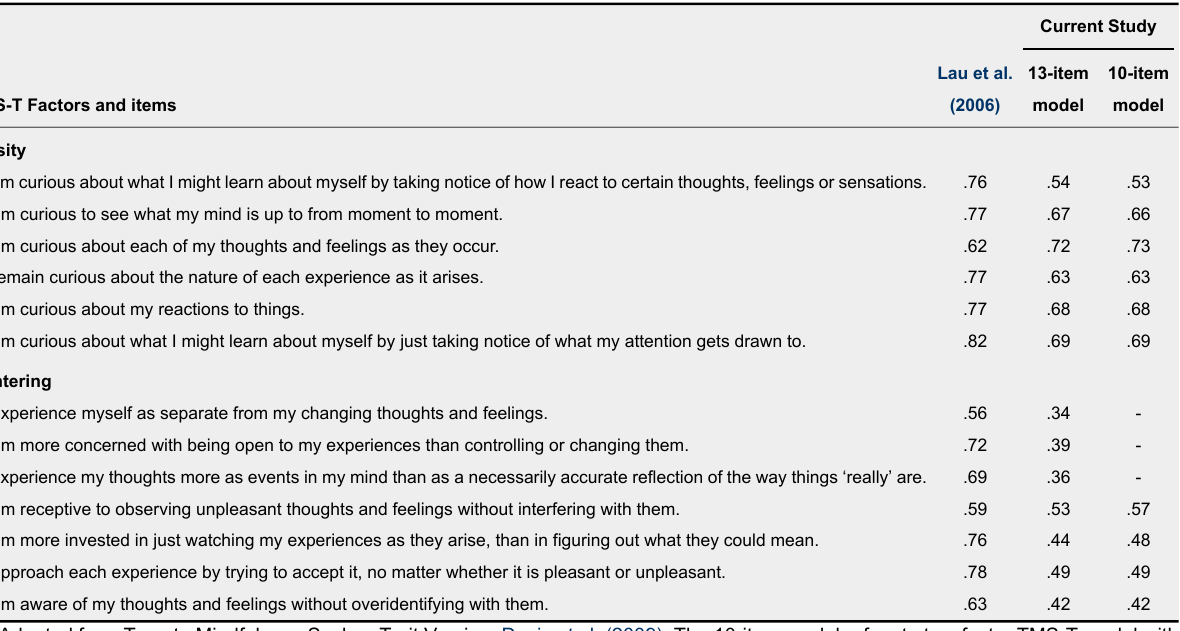
Comparisons of the Standardized Factor Loadings Obtained from Lau et al. (2006) With the Confirmatory Factor Analysis (CFA) Results of the Current Study